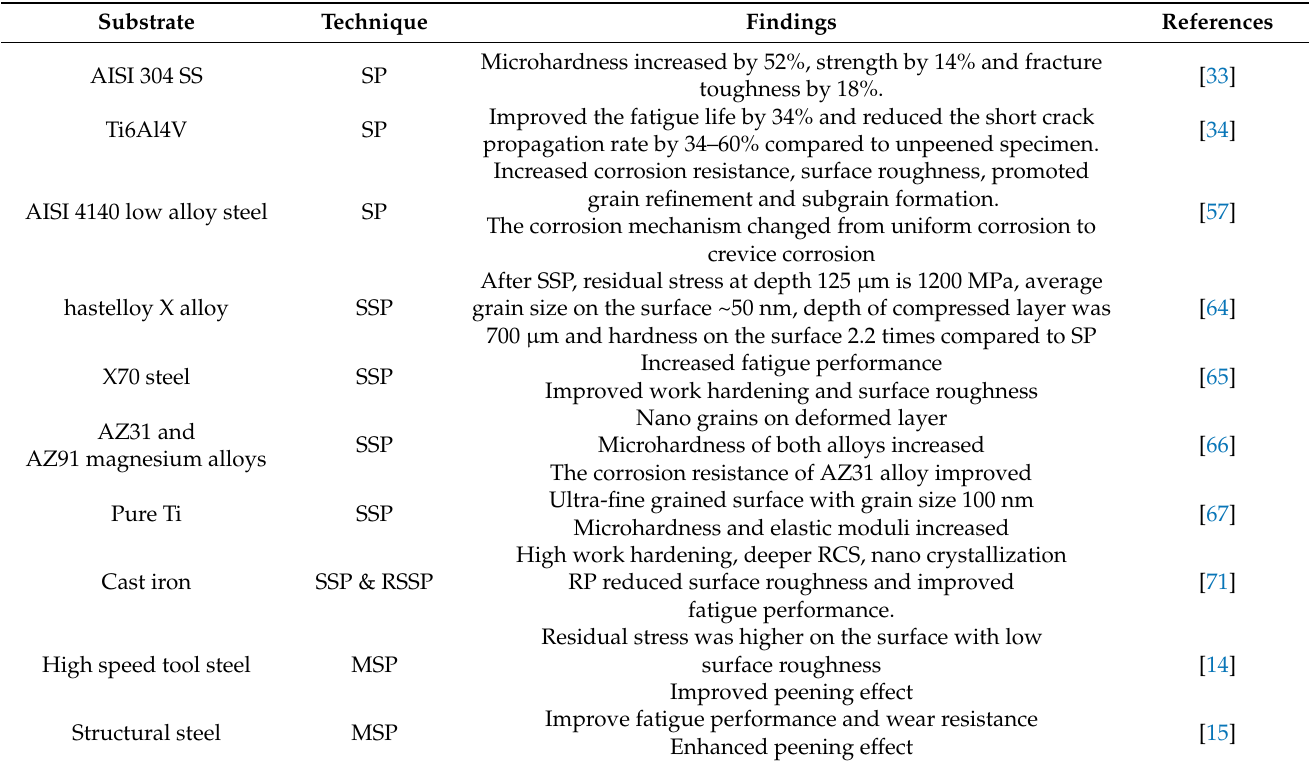
Table 1. Effect of classical and advanced SP techniques on engineering